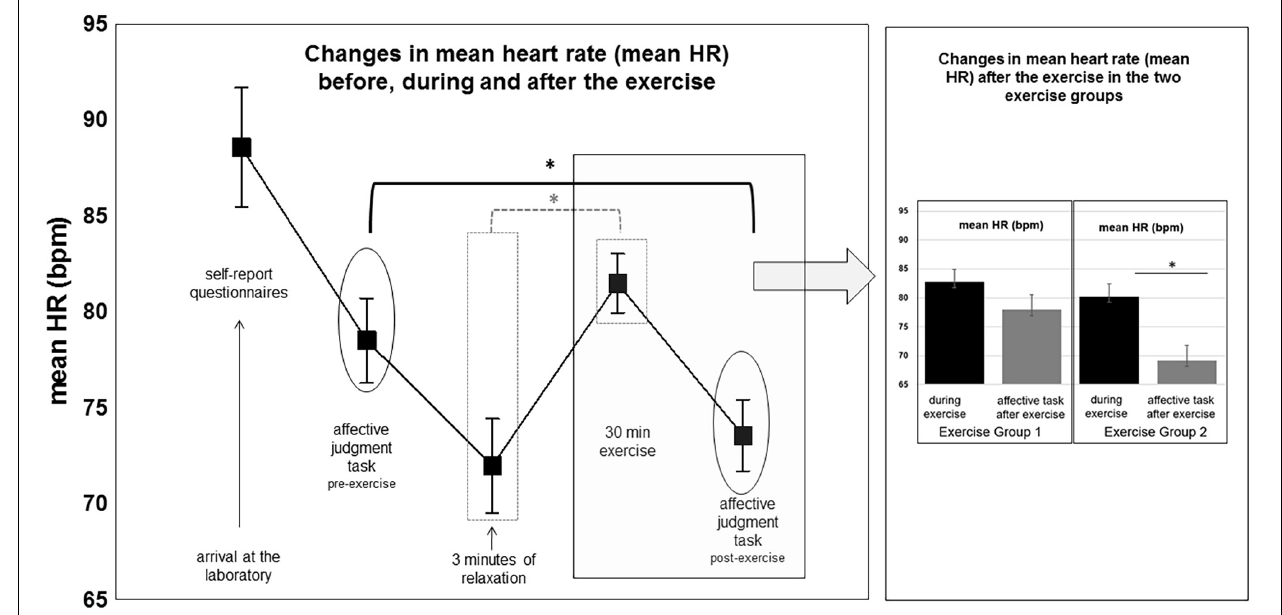
FIGURE 3 | Changes in mean HR across the different experimental conditions. For details, see